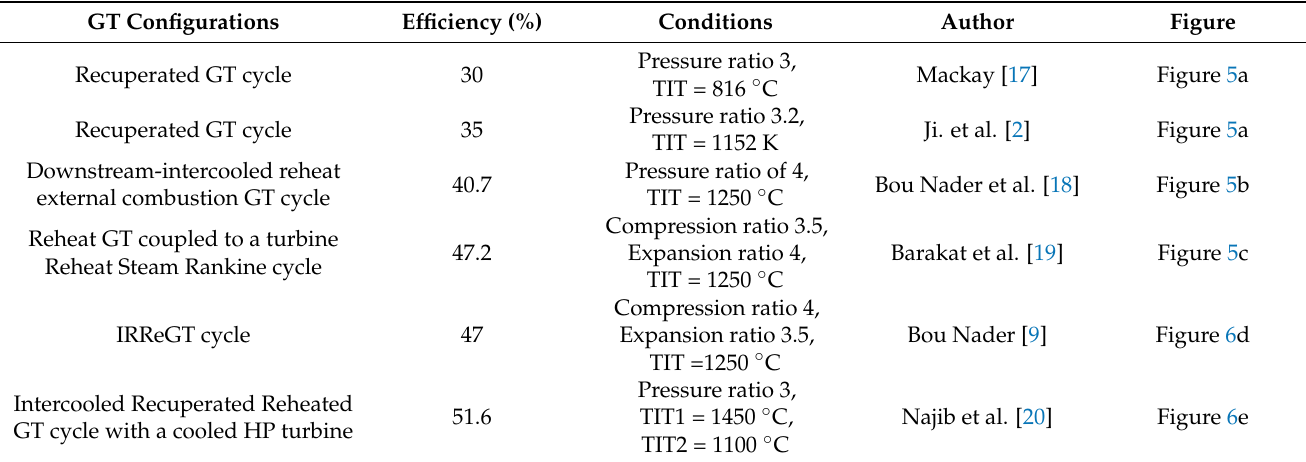
Table 3. Summary overview of the literature for GT configurations as range extenders for electric